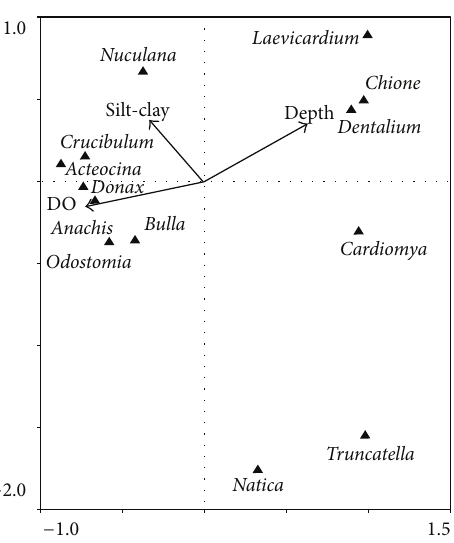
Figure 2: CCA analysis relations between dominant mollusks, dissolved oxygen (DO), silt-clay, and depth in Todos Santos Bay. First canonical axis ( 𝐹 = 3.454 , 𝑃 = 0.002 ); all canonical axes ( 𝐹 = 1.995 , 𝑃 = 0.004 ).